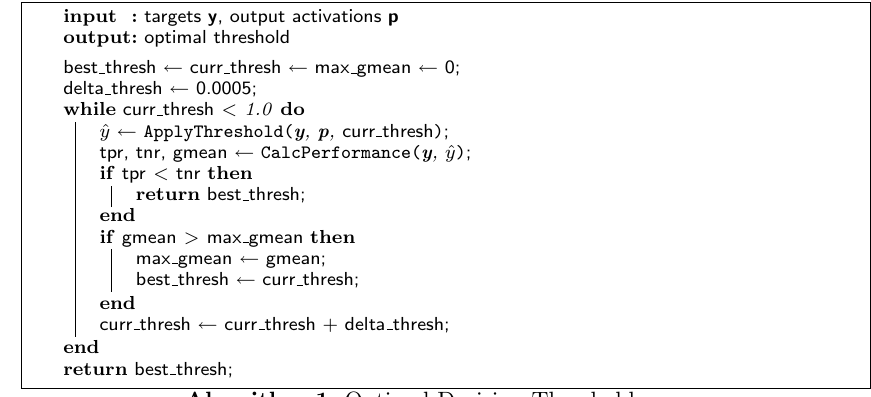
Algorithm 1: Optimal Decision